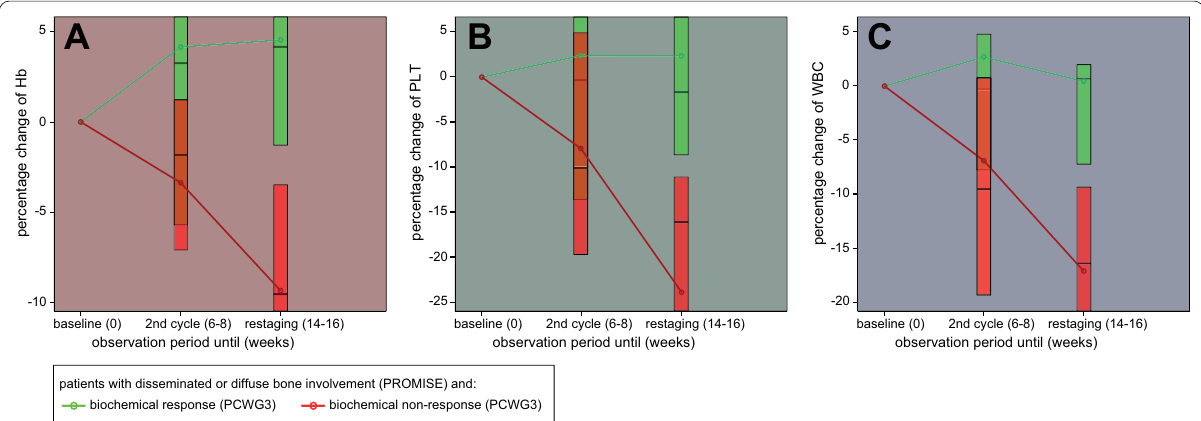
Fig. 2 Box plots of percentage changes (in relation to baseline) of haemoglobin ( A ), platelet count (PLT) ( B ) and white blood cell count (WBC) ( C ), at second cycle and at restaging, among patients with disseminated or diffuse metastatic bone involvement (PROMISE) categorised by biochemical response behaviour